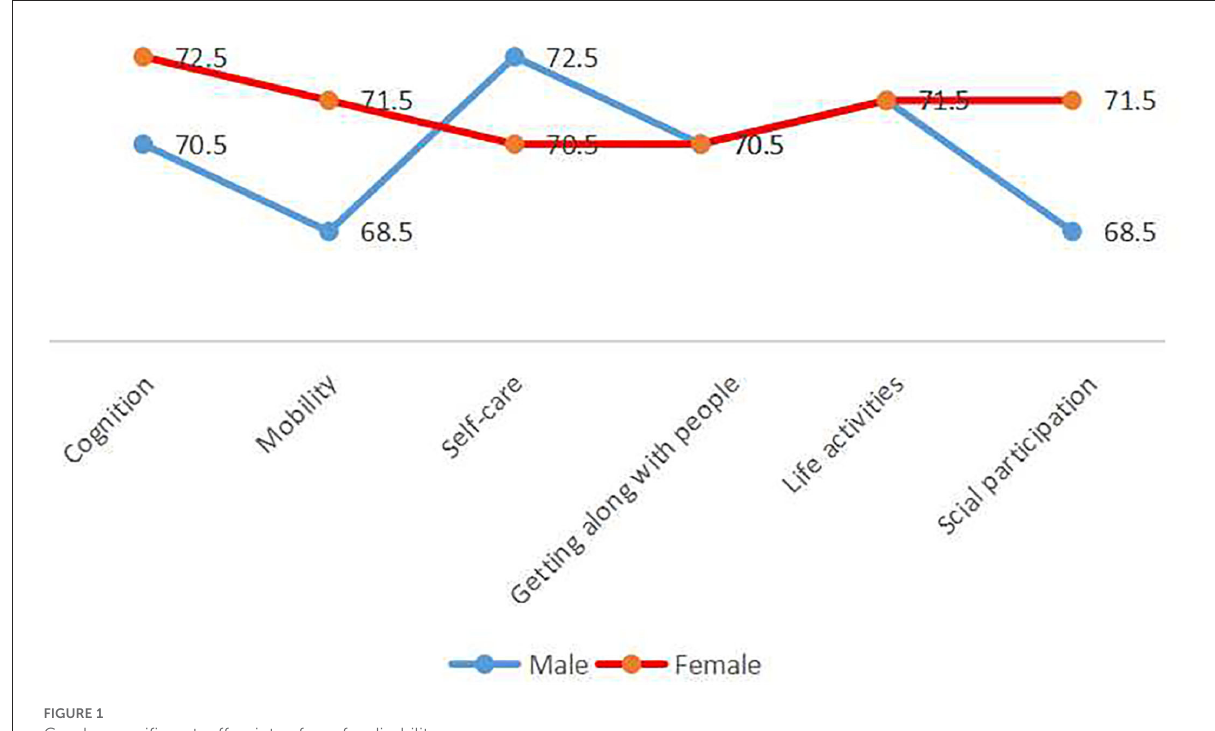
FIGURE1 Gender specific cut-off points of age for disability.